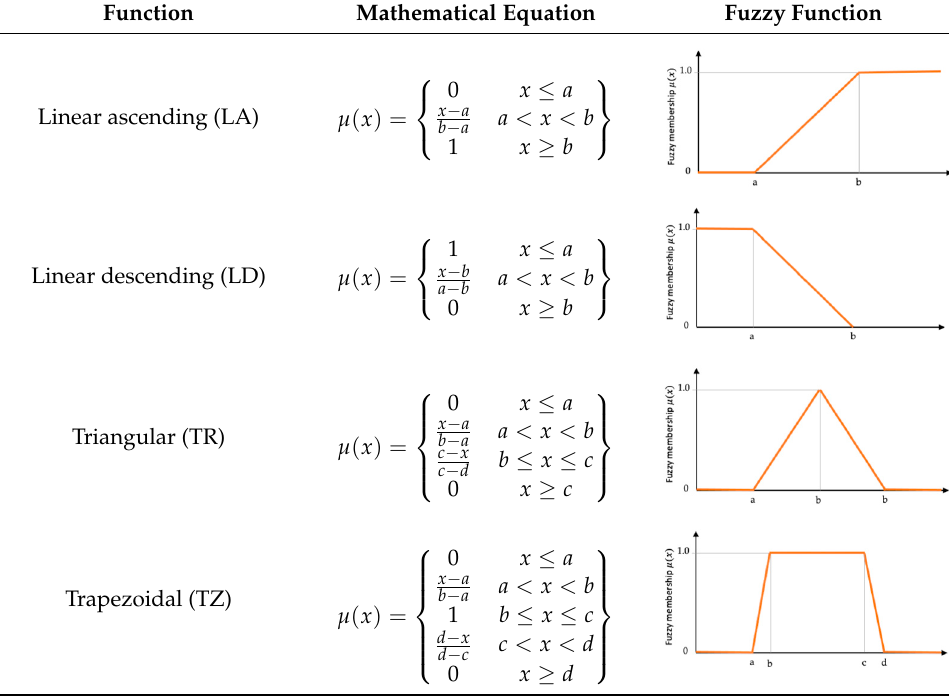
Table 1. Fuzzy membership functions